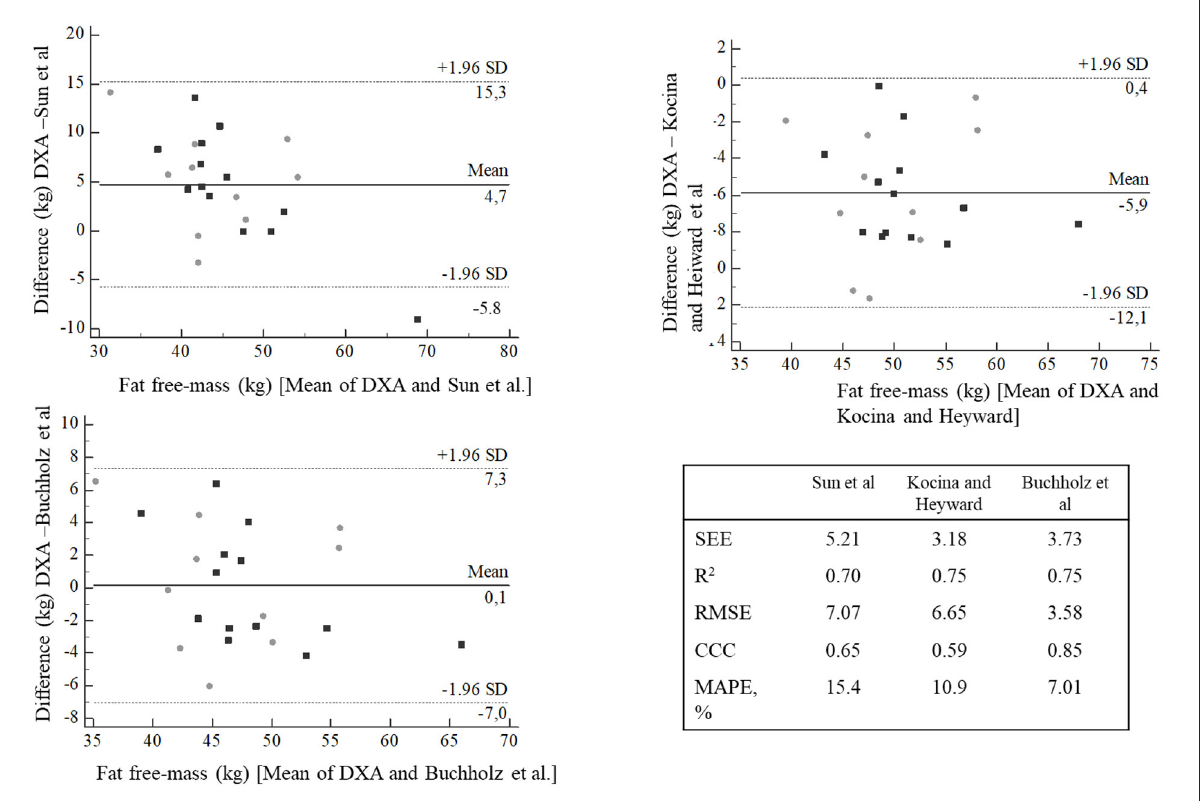
FIGURE1 Bland-Altman plots agreement between fat free-mass predictive equations compared with DXA. Gray circle = NPA, black square = PA. SEE, Standard Error of the Estimate; R 2 , coefficient of determination; CCC, concordance correlation coefficient; MAPE, mean absolute percentage